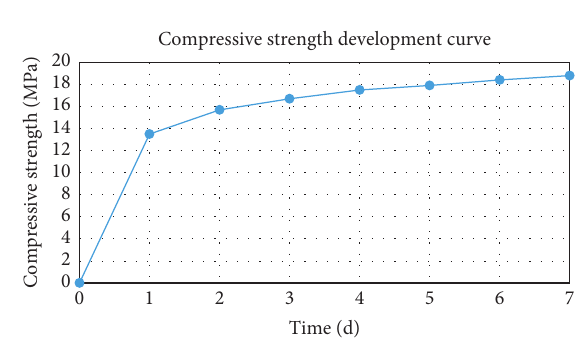
Figure 4: Compressive strength development Table 10: Formulation of the low-density cement slurry.